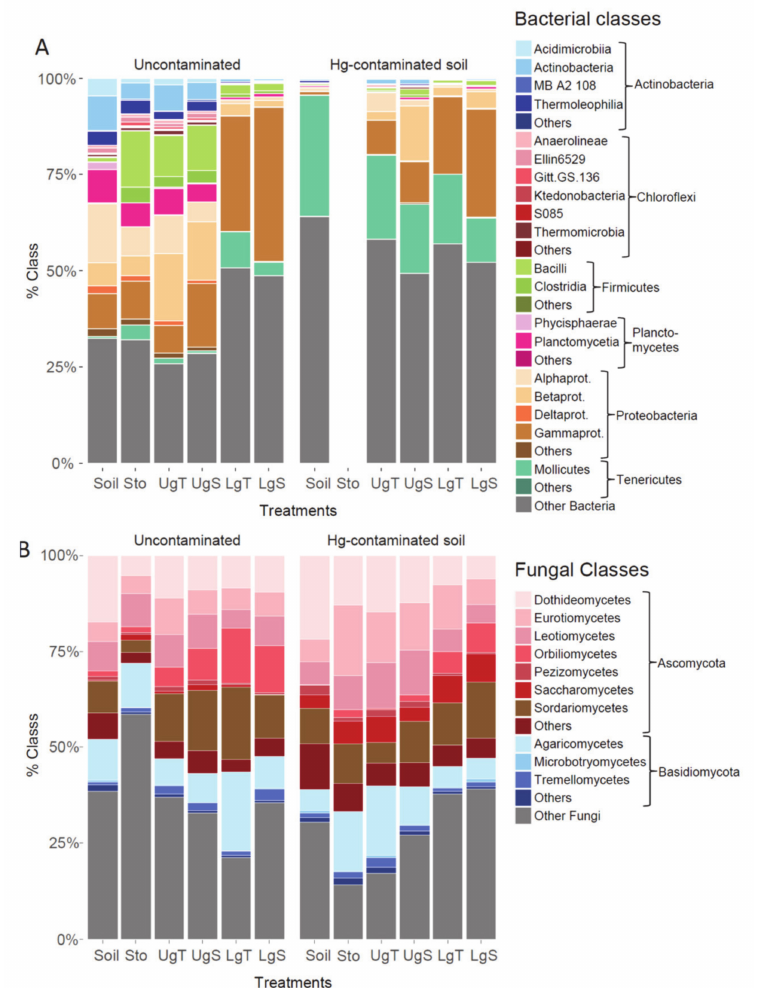
Figure 7. Relative abundance of bacterial ( A ) and fungal ( B ) phyla and classes across the treatments (Hg-contaminated, uncontaminated) and the sample types (soil, earthworm and cast) in experiment